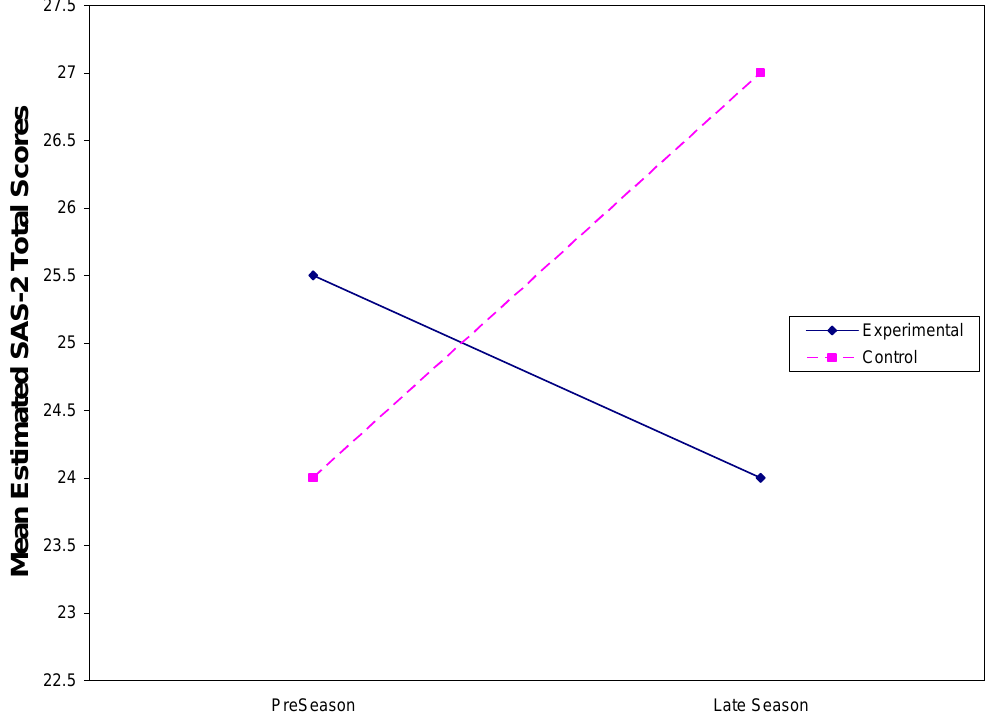
Preseason and late season estimated means for the intervention (MAC+MAPS) and control conditions on the SAS-2 total